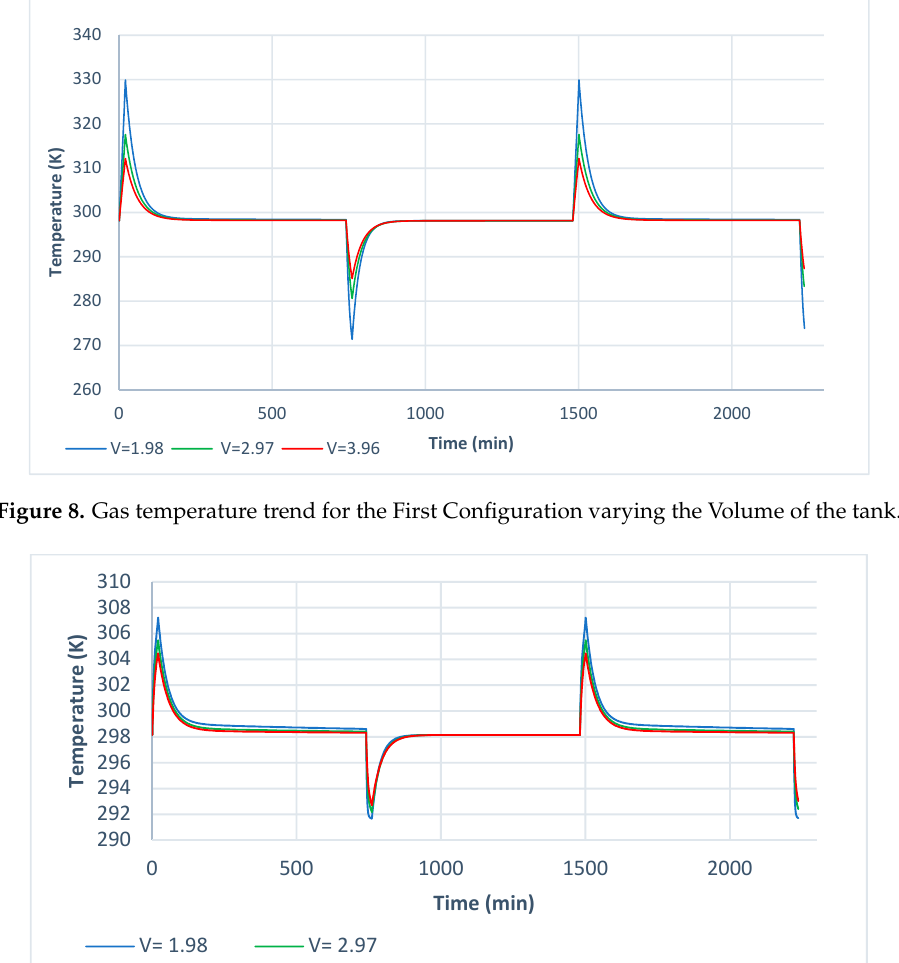
Figure 10. Pressure gas trend for the First Configuration varying the Volume of the tank. Figure 11. Pressure gas trend for the Second Configuration varying the Volume of the tank. The Figures 8–11 show that as the volume of accumulation increases, a reduction in gas pressure and temperature is obtained for both configurations.